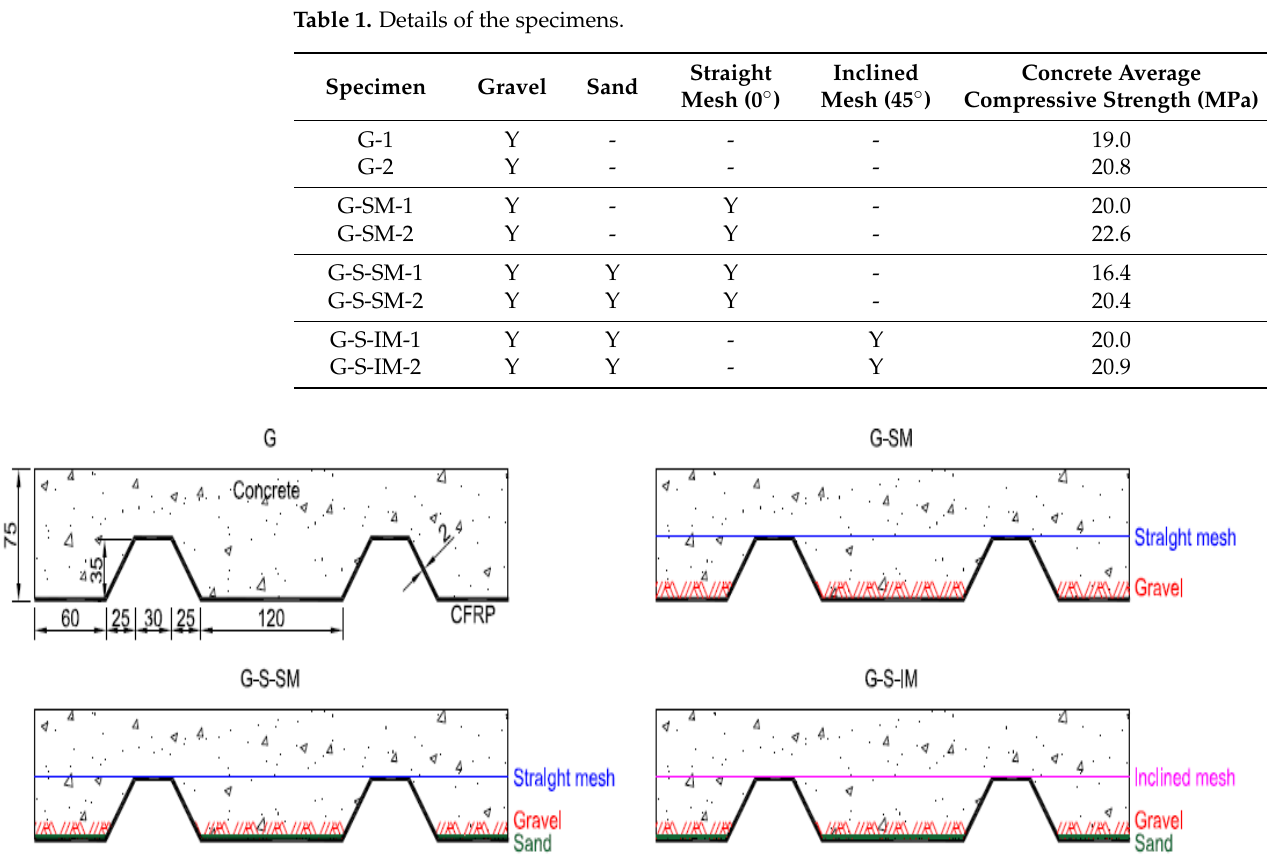
Table 1. Details of the specimens.